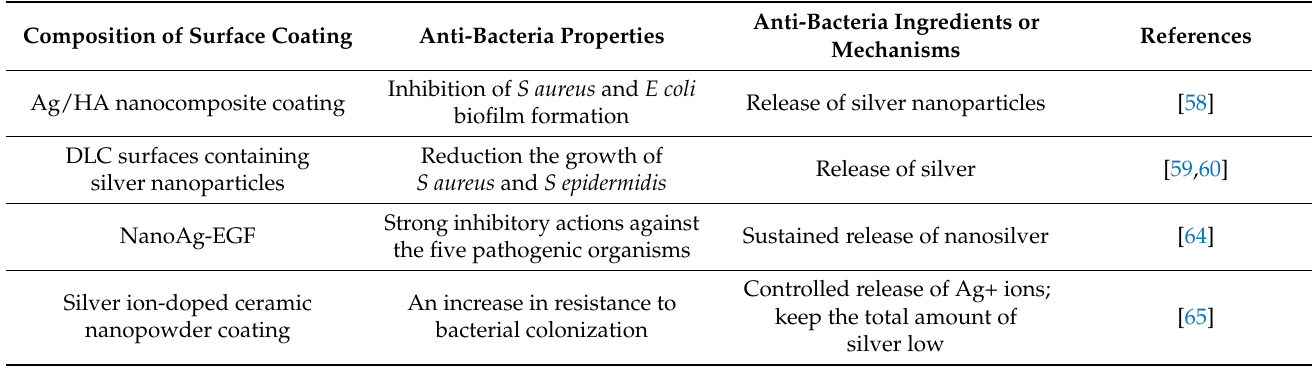
Table 2. Composition and antibacterial mechanism of nanocomposite